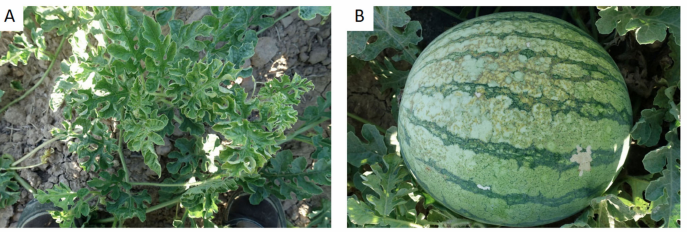
Figure 1. Mosaic symptomatic watermelon plants observed in the field ( A ), with a detailed picture of the affected fruit ( B ). Table 1. Watermelon and pumpkin samples grouped by year and locality. Four symptomatic samples showing mosaics were collected from different plots, and two replicates per each plant sample were tested by dot-blot hybridization for watermelon mosaic virus (WMV), Moroccan watermelon mosaic virus (MWMV), papaya ringspot virus (PRSV), cucumber mosaic virus (CMV), and zucchini yellow mosaic virus (ZYMV). (-); non-detected. PositiveSamplesforVirusTested CucurbitPlant Locality N ◦ Plots